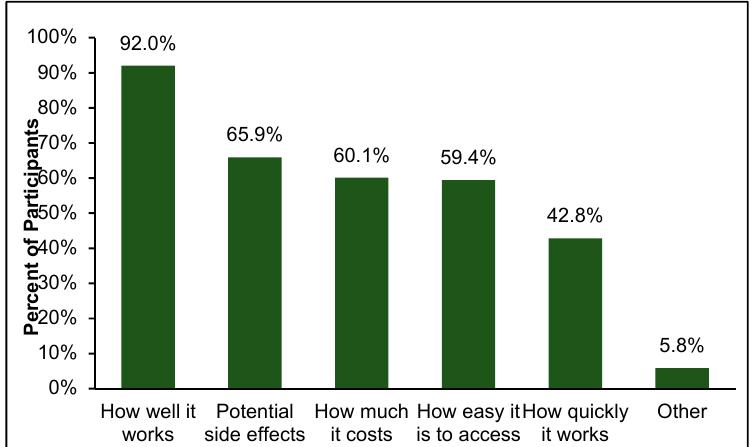
Figure 8. Important factors to participants when considering anxiety treatment.